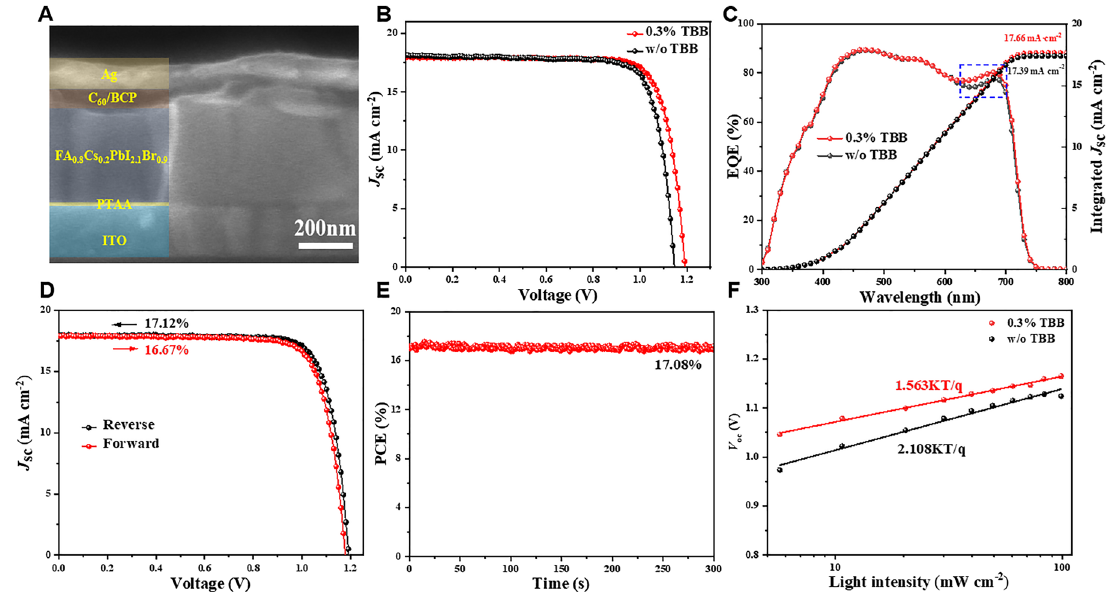
Figure 6: Device structure and performance. (A)Cross-sectionalimageofourwide- E g perovskitedevice.(B) J-V characteristicsand(C)externalquantumef fi ciency(EQE)spectraofthebest- performing device without 1,3,5-tris (bromomethyl) benzene (TBB) and with 0.3% TBB under forward voltage scan. (D) J-V curves of the 0.3% TBB device under reverse and forward voltage scans. (E) Steady-state power conversion ef fi ciency (PCE) of the 0.3% TBB device. (F) Dependence of the V oc on light intensity for the control device and the 0.3% TBB device.